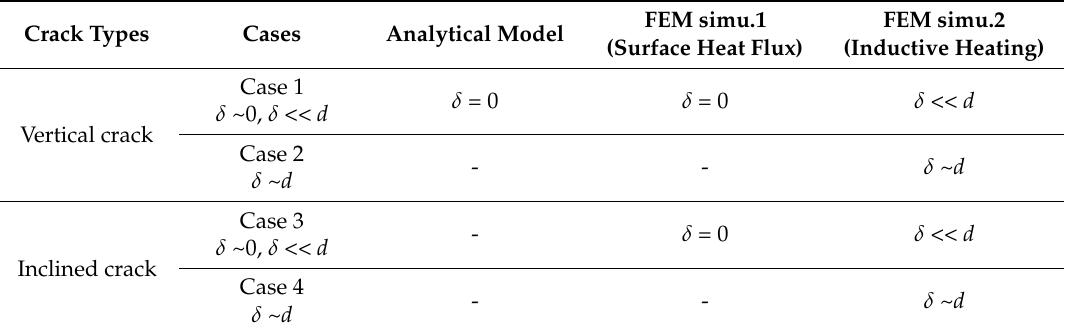
Table 2. The models and four cases for which the models can be applied ( d : crack depth; δ : eddy current penetration depth).